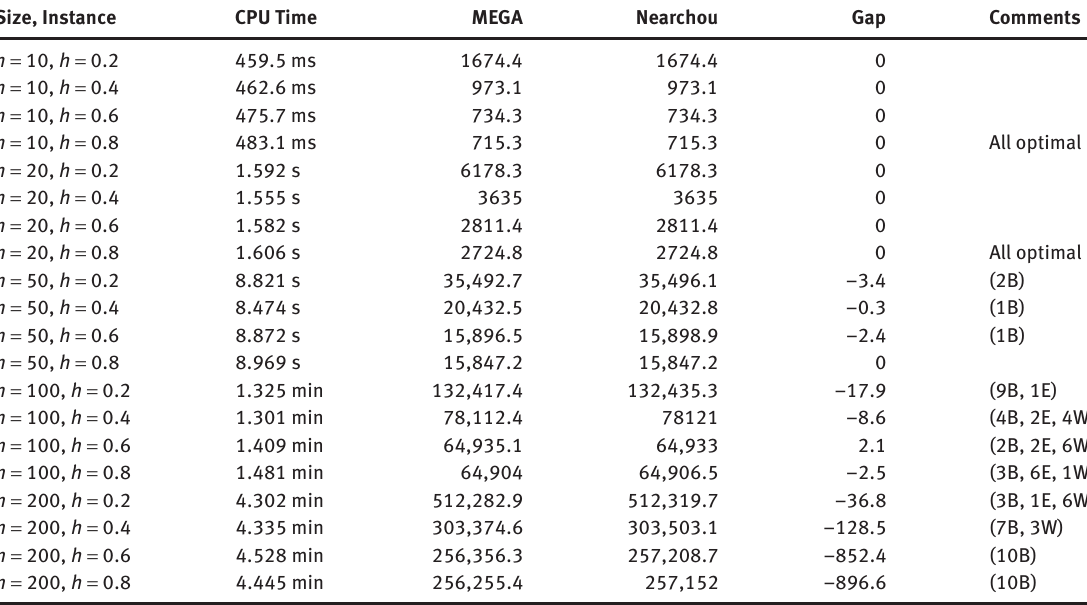
Table 1: MEGA Results Compared with Nearchou’s Average of Best Results. Size, Instance CPU Time MEGA Nearchou